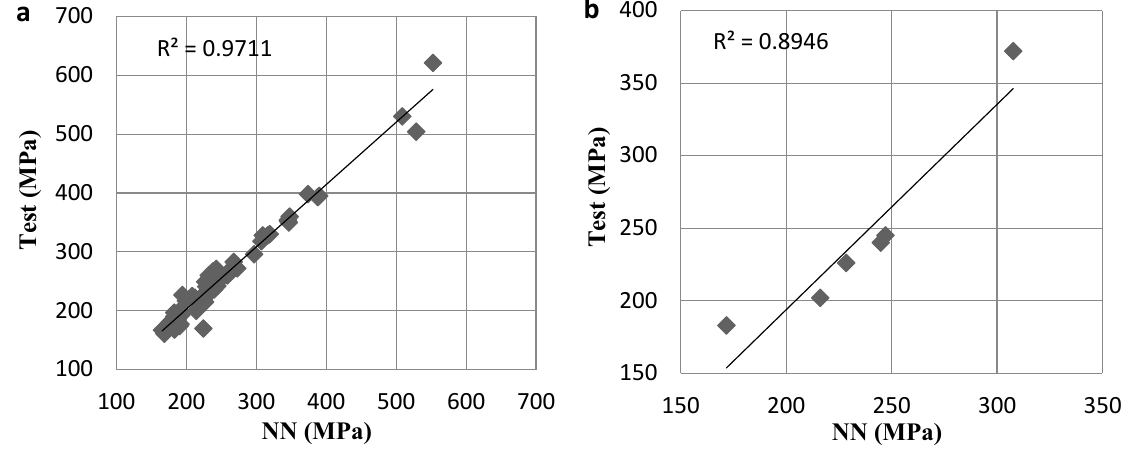
Figure 1. Correlation of NN and Test ( a ) Training set ( b ) Testing